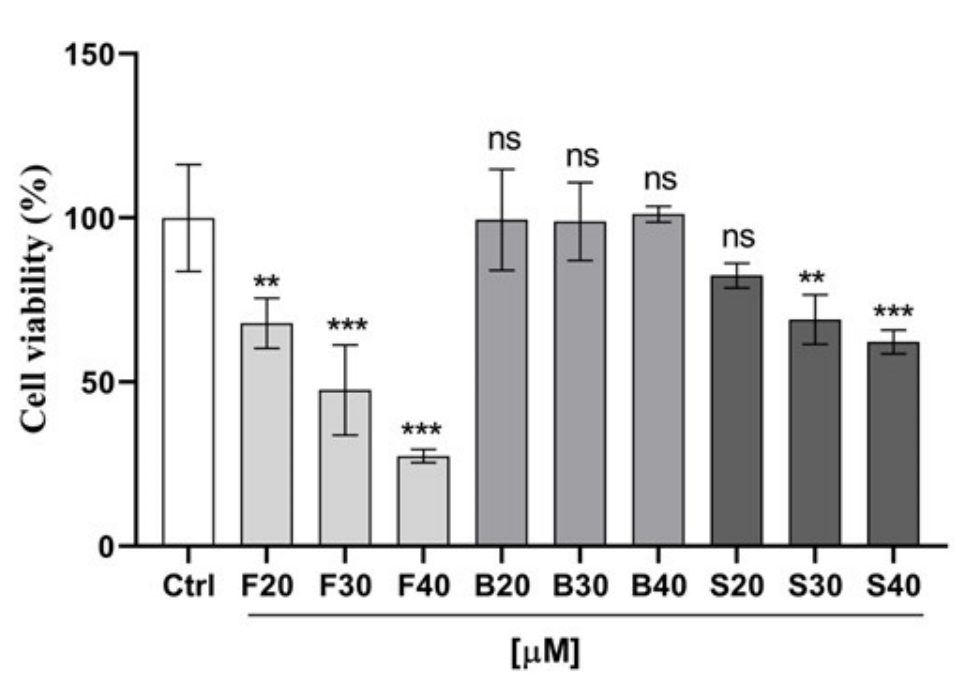
Figure 9. Effect of optimized formulation (F), suspension (S), blank (B), and control (C) on the cell viability of MCF-7 cancer cells after 24h treatment. Error bars are represented as mean ± SD (n = 4). Statistical analysis was performed using Turkey multiple comparisons (2-way ANOVA). p values are ** p > 0.01; *** p > 0.001 and ns < 0.05.